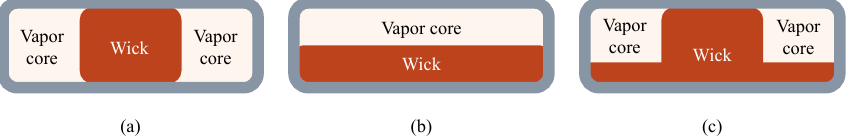
Figure 1. Cross-section of flat heat pipes with different internal structures: ( a ) Spaced structure. ( b ) Layered structure. ( c ) Composite